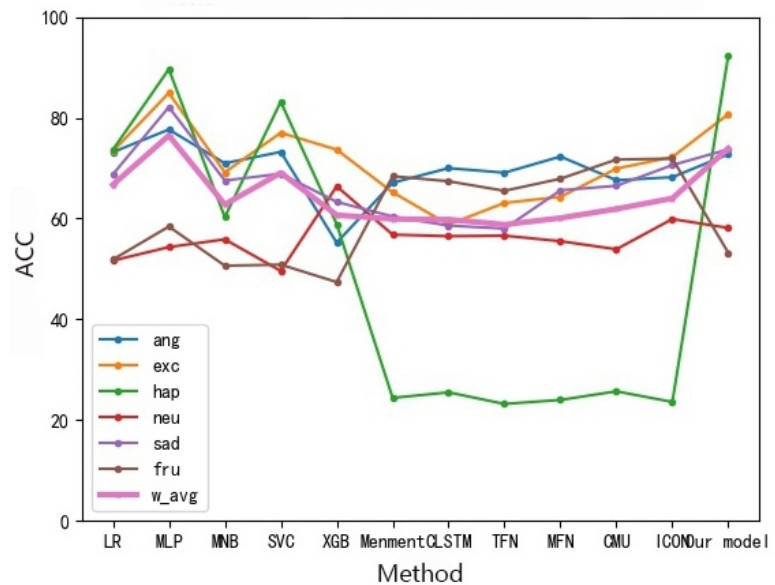
Figure 13. Fine-grained Emotion Accuracy Rate Analysis of Different MOCAP Methods